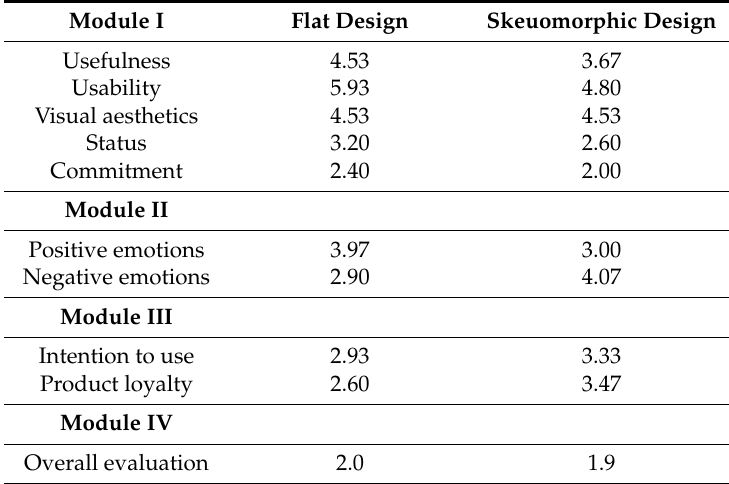
Table 20. meCUE scores for flat and skeuomorphic design.